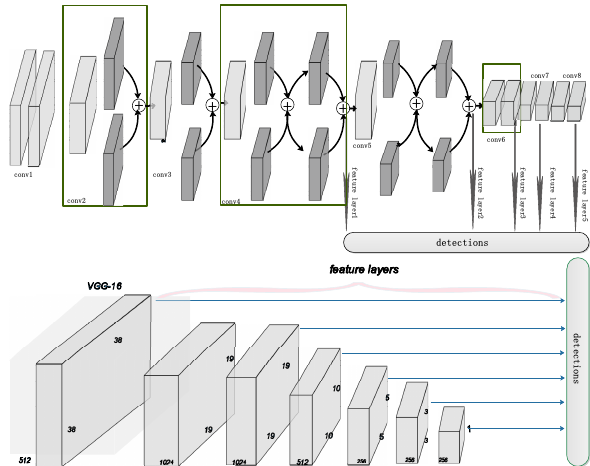
Figure 1. comparison between SSD model and proposed model. Different from SSD, the network structure is not simply a stack of convolutional layers. The idea is by increasing the width of the network in the GooLeNet to make feature learning more accurate. Our model use 3 × 3 kernels and 5 × 5 kernels to learn features and combine them together as the input of the next layer. Both of the two models use several feature layers to get anchors.